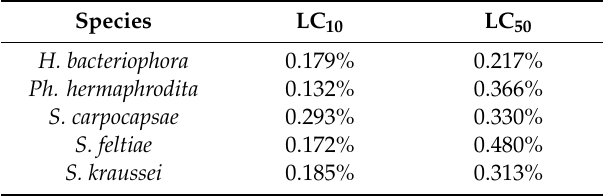
Figure 4. Mortality after 24-h exposure time of Steinernema feltiae juveniles of 0.1%, 0.3%, 0.6%, and 1% NLE ( A ) and 0.001%, 0.003%, 0.006%, and 0.01% of NA ( B ). (One-way ANOVA, Tukey’s pairwise comparisons ( A ), Mann–Whitney U test ( B ); the same letters indicate no significant difference at p < 0.05 level) .